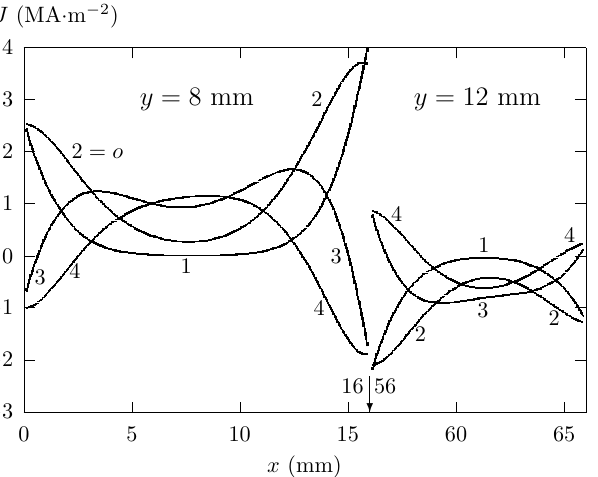
Figure 2. Example 1, α = 0, f = 1 kHz: The dependences of current density on x and t for a constant y in the conductors A 1 and A 2 . The curve marked by the character o represents the current density T /4; J = 0 for t = 0. The axis x at the point marked by the arrow ends in the value at time t = o × x = 16 mm and continues with the value x = 56 mm. Between these values is the gap between the conductors, and the current density is